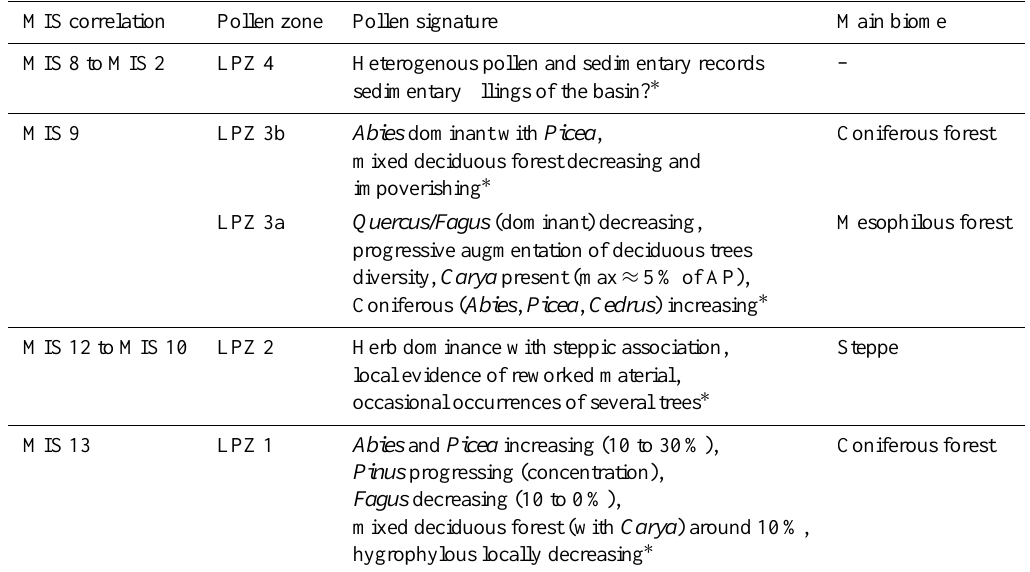
Table 1. Isotopic correlations and summary description of the palynological sequence of the Boiano Basin, including main biome deduced from pollen assemblages (from Orain et al., 2012).